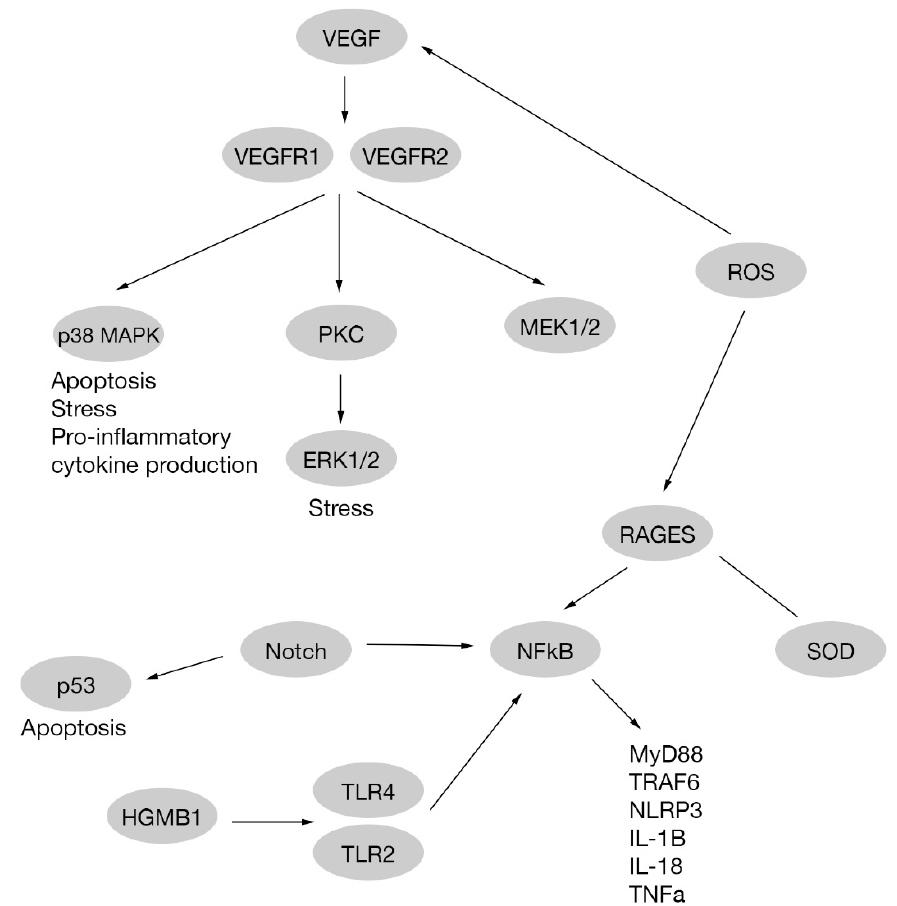
Figure 2. Pathways scheme for vascular endothelial growth factor, mitogen-activated protein kinase cascades, nuclear factor-kappa B and reactive oxygen species in RGC cells.